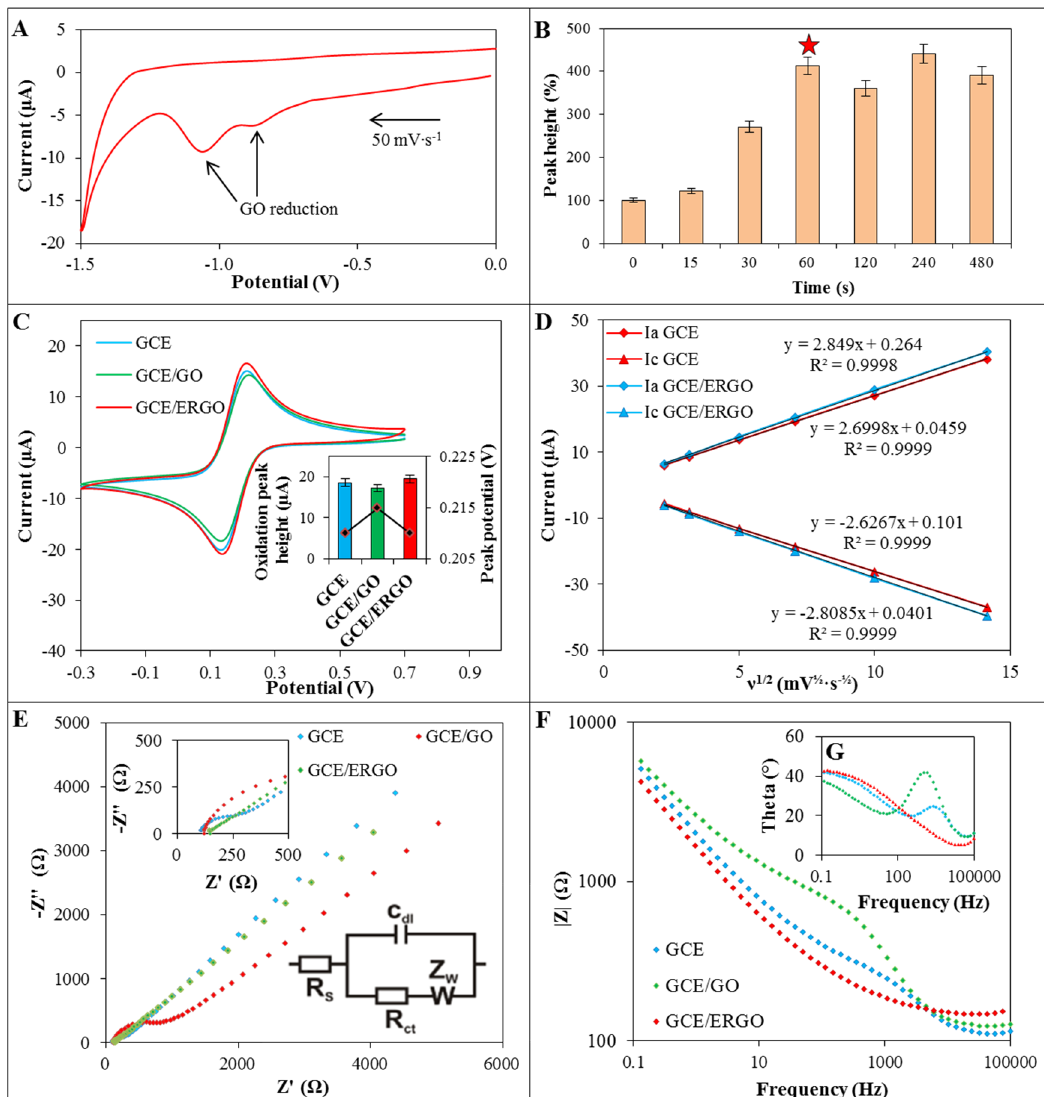
Figure 2. ( A ) The CV (0 − ( − 1.5) V) of GCE/GO in acetate buffer; ( B ) Dependence of Zn(II) reduction signal obtained using GCE/ERGO on deposition time of GO (0.5 mg ∙ mL − 1 ) on the electrode (deposition time selected as optimal is marked with star); ( C ) CV of 2 mM [Fe(CN) 6 ] 3 − /[Fe(CN) 6 ] 4 − in 0.1 M KCl (50 mV ∙ s − 1 ) recorded on bare GCE (blue line), GCE/GO (red line) and GCE/ERGO (green line) and corresponding peak current levels; ( D ) The dependence of [Fe(CN) 6 ] 3 − /[Fe(CN) 6 ] 4 − anodic (Ia) and cathodic (Ic) peak heights on the square root of scan rate; ( E ) Nyquist plot, detail of nyquist plot high frequency region and equivalent circuit used for data evaluation in insets; ( F ) Bode modulus plot of bare GCE (blue line), GCE/GO (red line) and GCE/ERGO (green line); and ( G ) corresponding Bode phase diagram (same colours as previous figure).